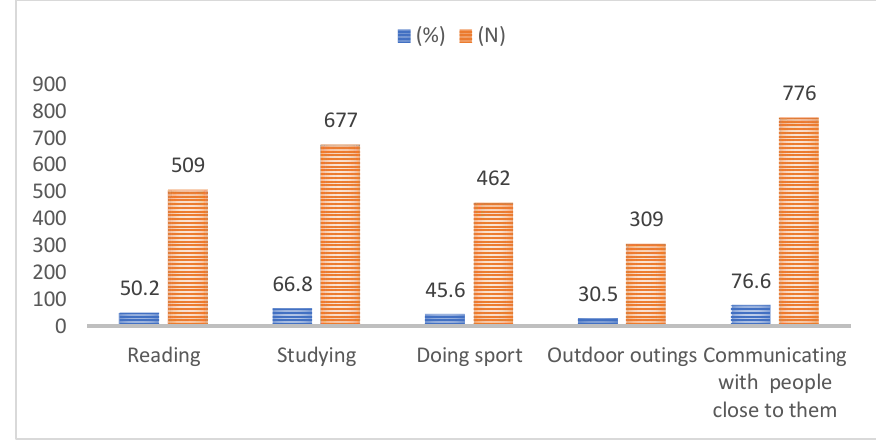
Figure 2. Activities that students did not give up during the state of emergency. Of the participants who did not keep in touch with the university, 66% also stated that